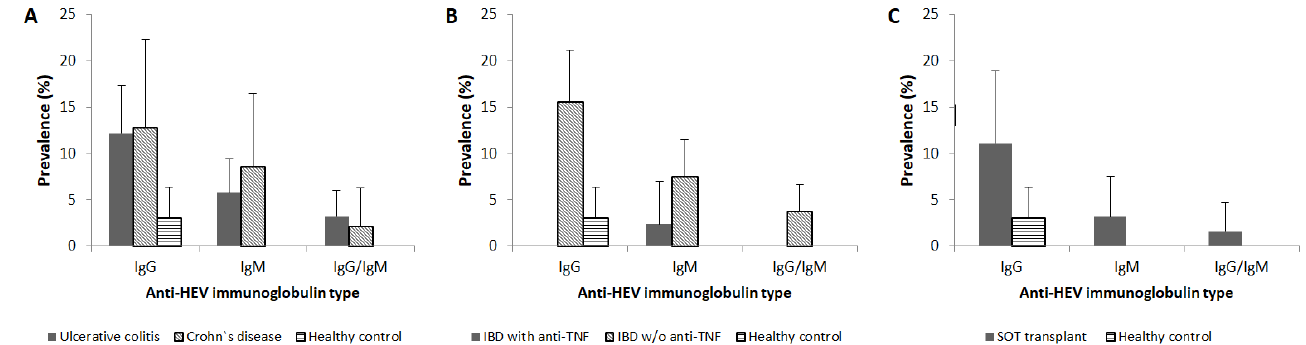
Figure 1. Seroprevalence of HEV in ( A ) IBD types, ( B ) IBD patients with or without anti-TNF treatment, and ( C ) SOT recipients, compared to the healthy control. IgG—immunoglobulin G; IgM—immunoglobulin M; w/o—without. Table 2. Seroprevalence of anti-HEV IgGs in healthy control and test groups.